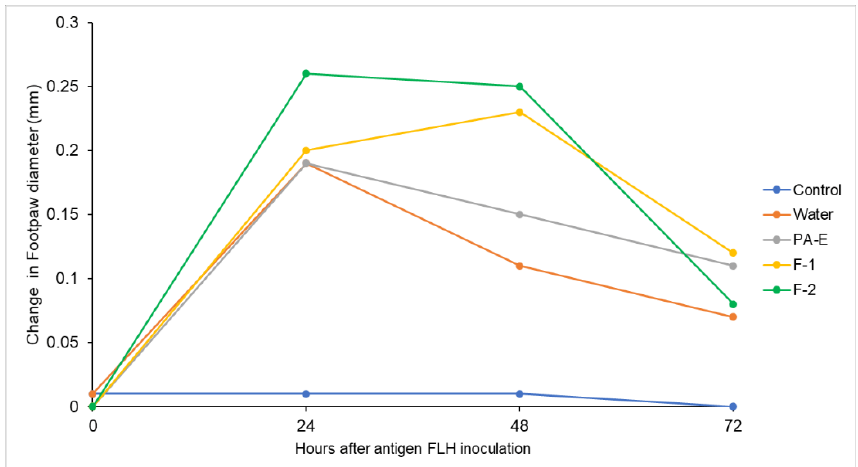
Figure 16. Delayed-type hypersensitivity (DTH) test expressed as change in footpad thickness for each treatment measured at 0, 24, 48 and 72 h.